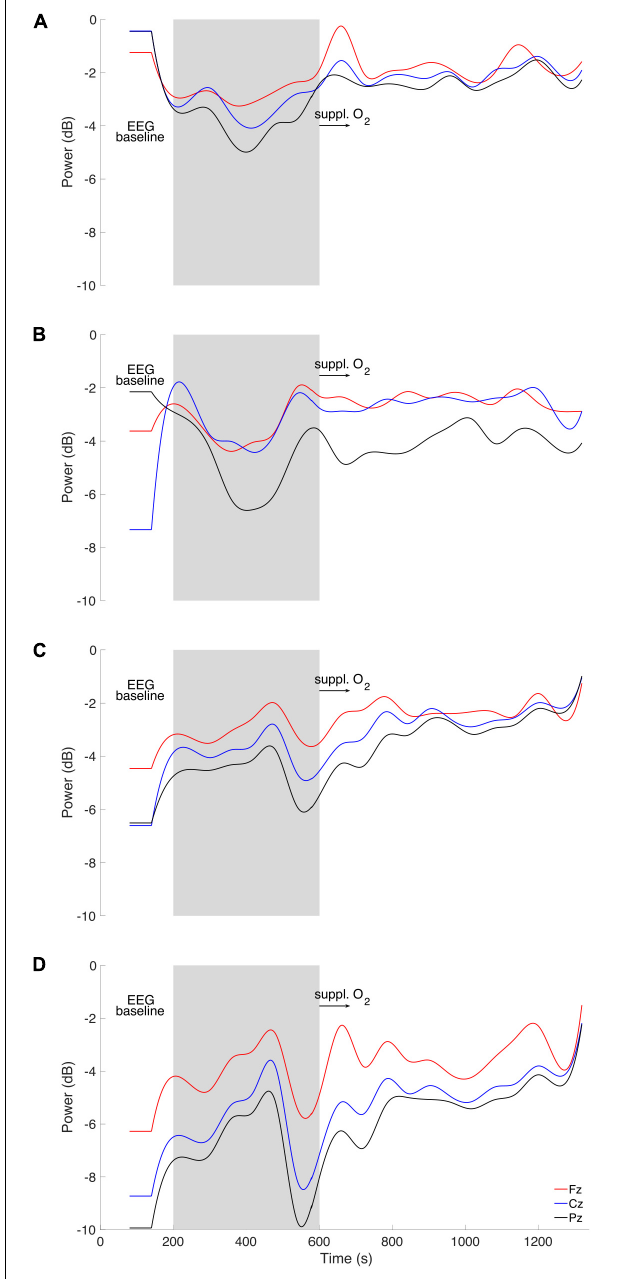
FIGURE 3 | Time course of EEG (A) theta, (B) alpha, (C) beta, and (D) gamma power (in decibel; dB) for frontal (Fz, red), central (Cz, blue) and posterior (Pz, black) electrodes are displayed for three phases: Baseline (0–200 s), vasovagal reaction (gray area, 200–600 s), and recovery period (600–1200 s) with brief 100% medical oxygen administration (black arrow, 600–700